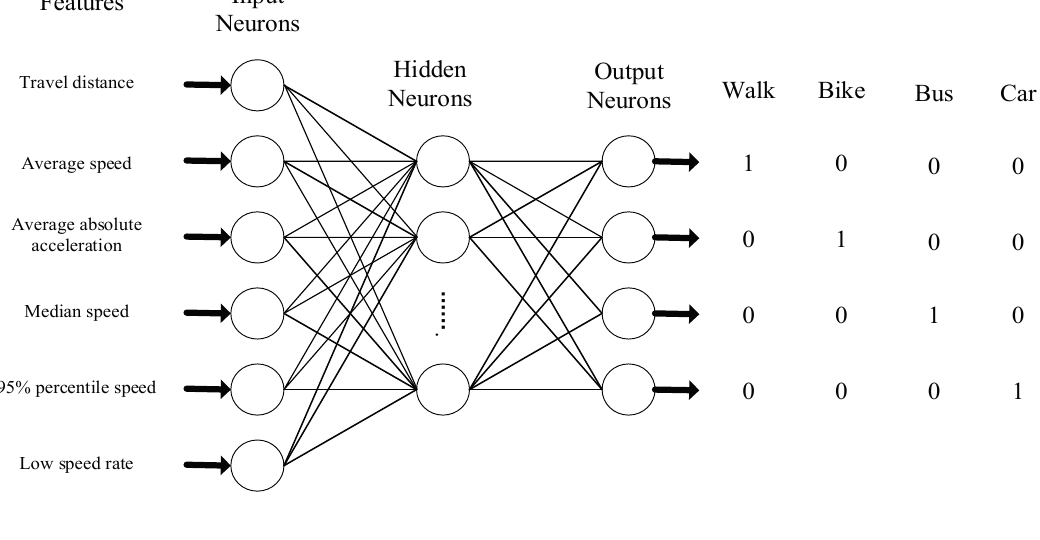
Figure 2. Three-layer neural